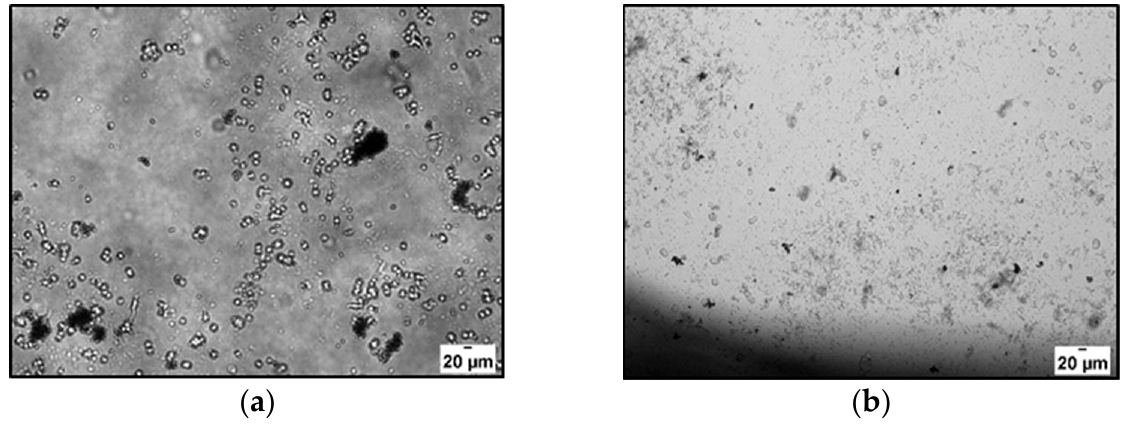
Figure 7. Optical microscope images of HBEpC after ( a ) 24 and ( b ) 48 h of incubation with H ALG-GO .